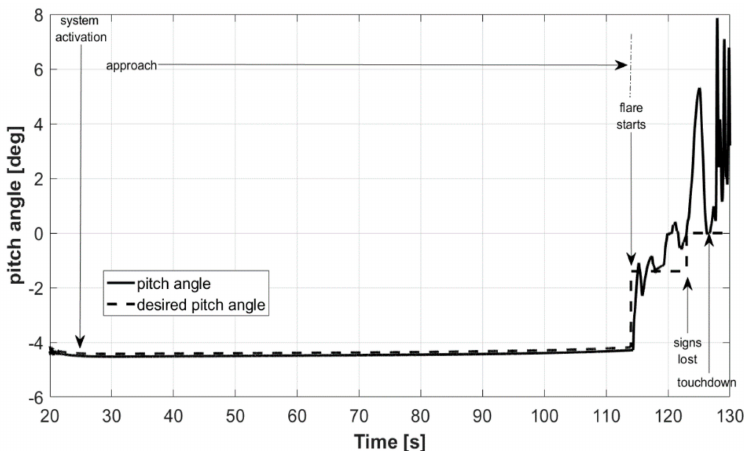
Figure 18. Pitch angle in all